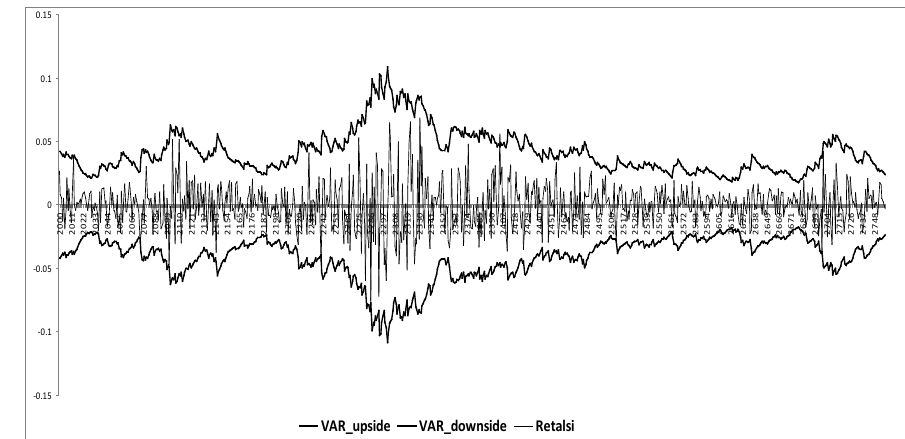
FIGURE 6: EGarch-GPD Source: Authors’ calculations, based on JSE ALSI return